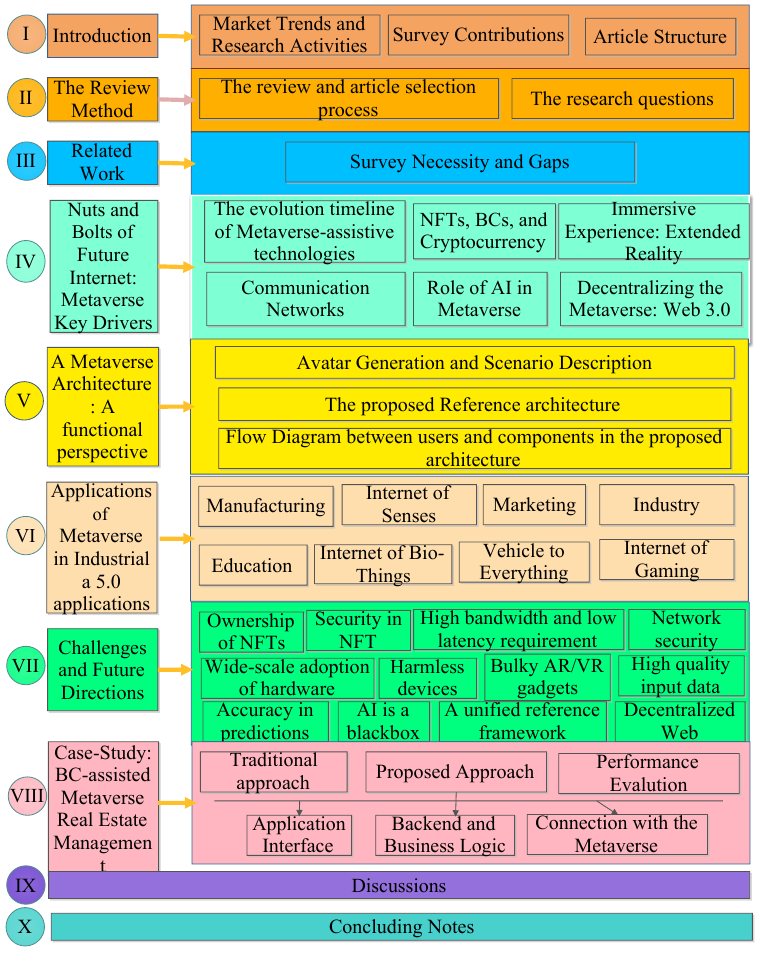
Figure 1. Organization and reading